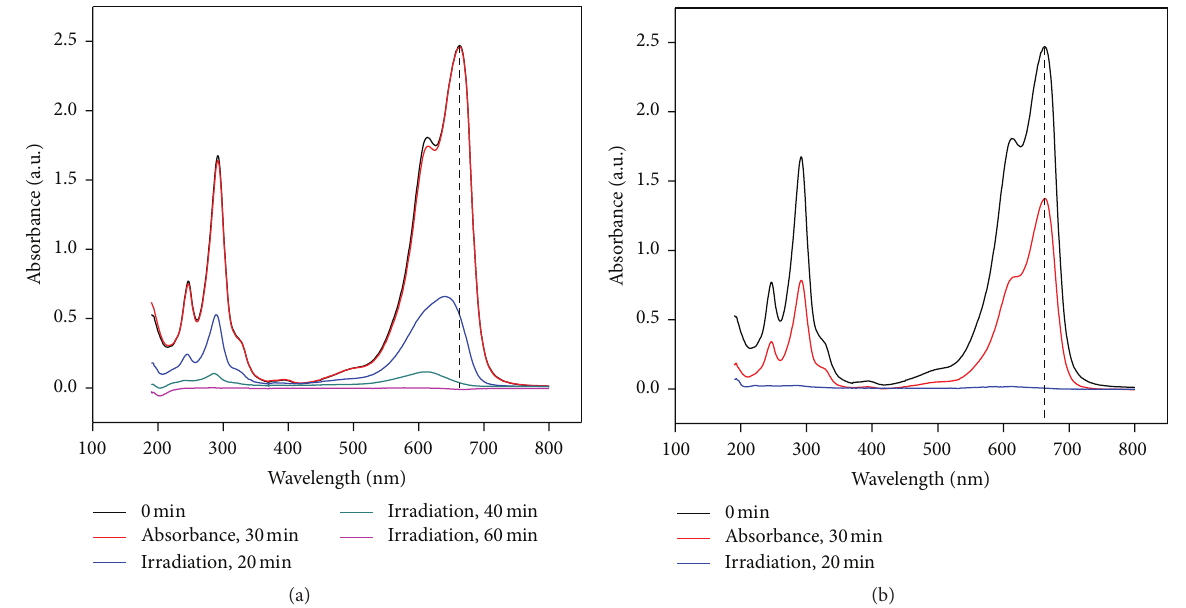
Figure 6: UV absorption spectra of MB solution after reacting with TiO 2 (a) or TiO 2 /diatomite composite (b) at different time.